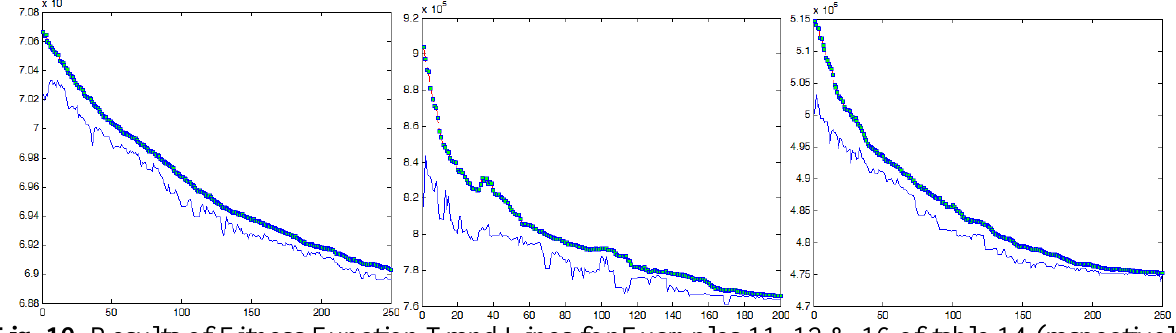
Fig. 19. Results of Fitness Function Trend Lines for Examples 11, 12 & 16 of table 14 (respectively) Comparing Results of Lingo 12.0 and the proposed GA for solving a number of experiments 2 Problem w Number of Int. Vars.* R o